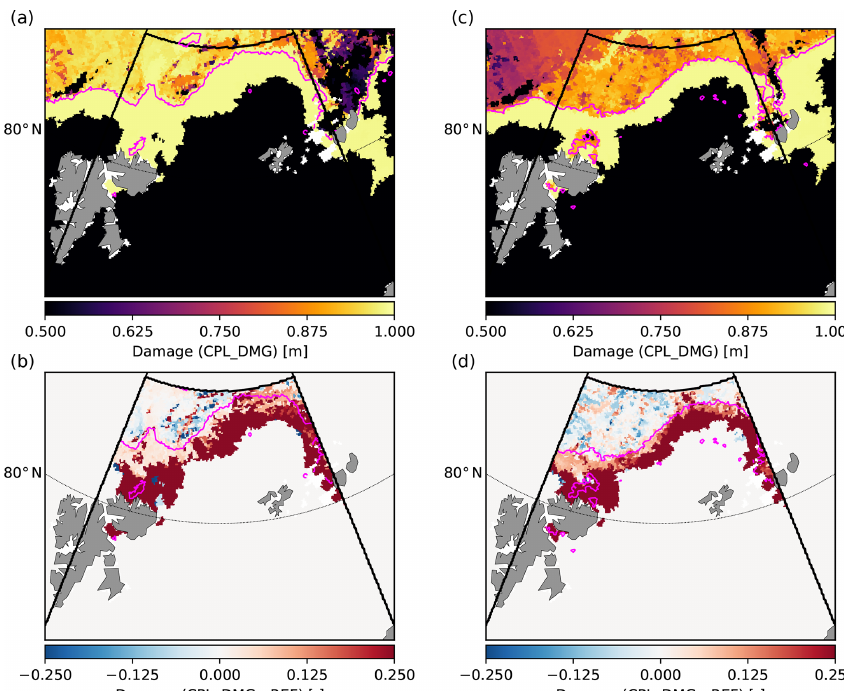
Figure 11. Snapshots of the distributions of sea ice damage in the CPL_DMG simulation (a, c) and of the differences in damage between the CPL_DMG and REF simulations (b, d) in the Barents Sea taken on 16 October 2015 at 18:00:00GMT (a, b) and on 21 October 2015 at 09:00:00GMT (c, d) . The magenta line corresponds to the contour D max = 200m in CPL_DMG. The black thick lines delimit the domain used to analyse the results from the three simulations (REF, CPL_WRS and CPL_DMG) in Figs. 9, 12 and